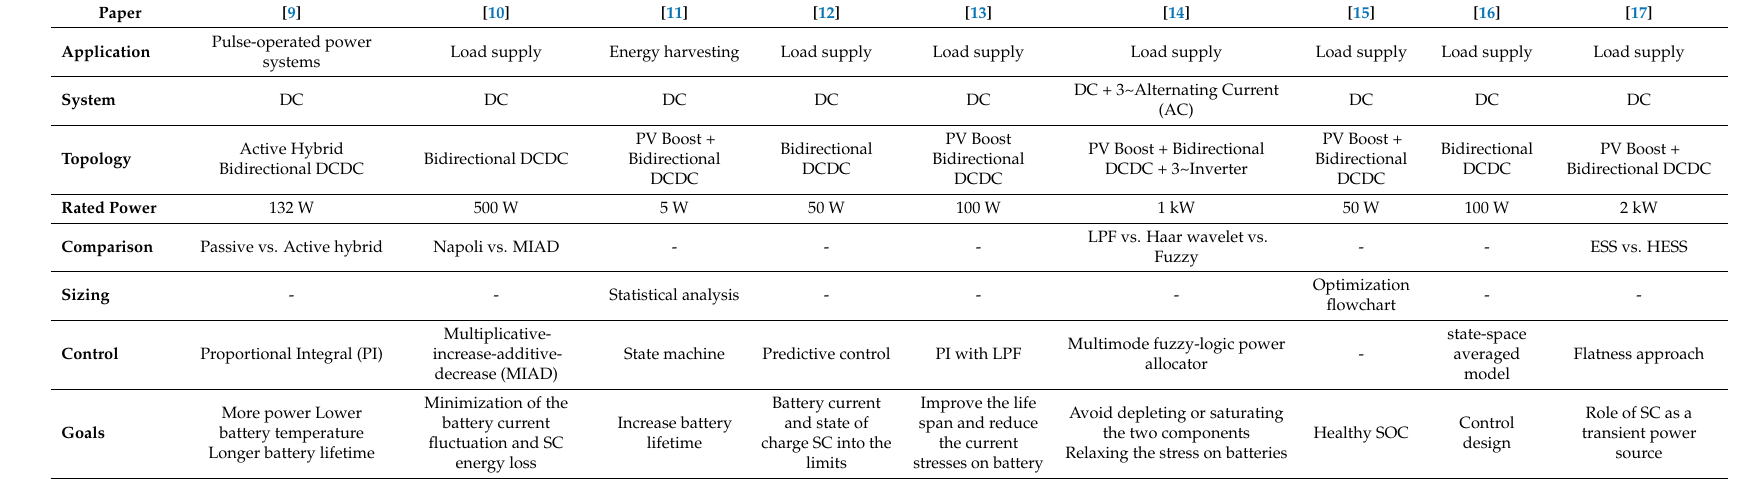
Table 1. Summary of HESS smaller than 5 kW in the literature.